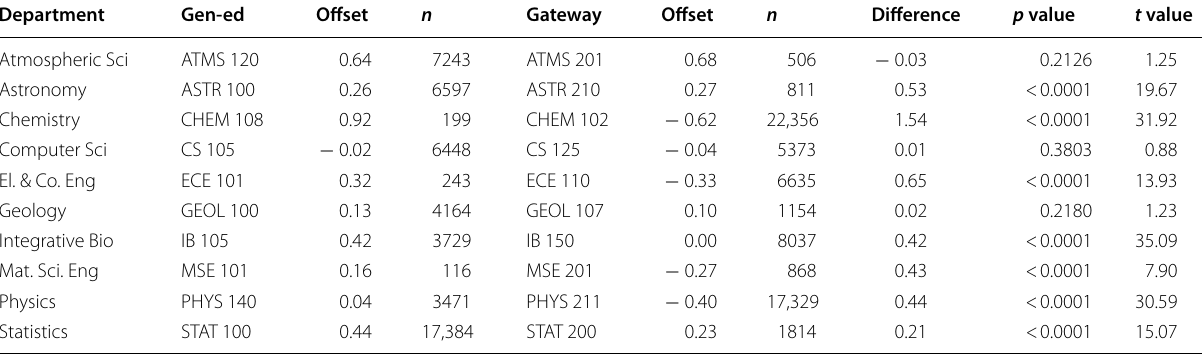
Table 2 Comparisons of largest general education course (“Gen-ed”) offered by ten STEM departments and that department’s first course for majors